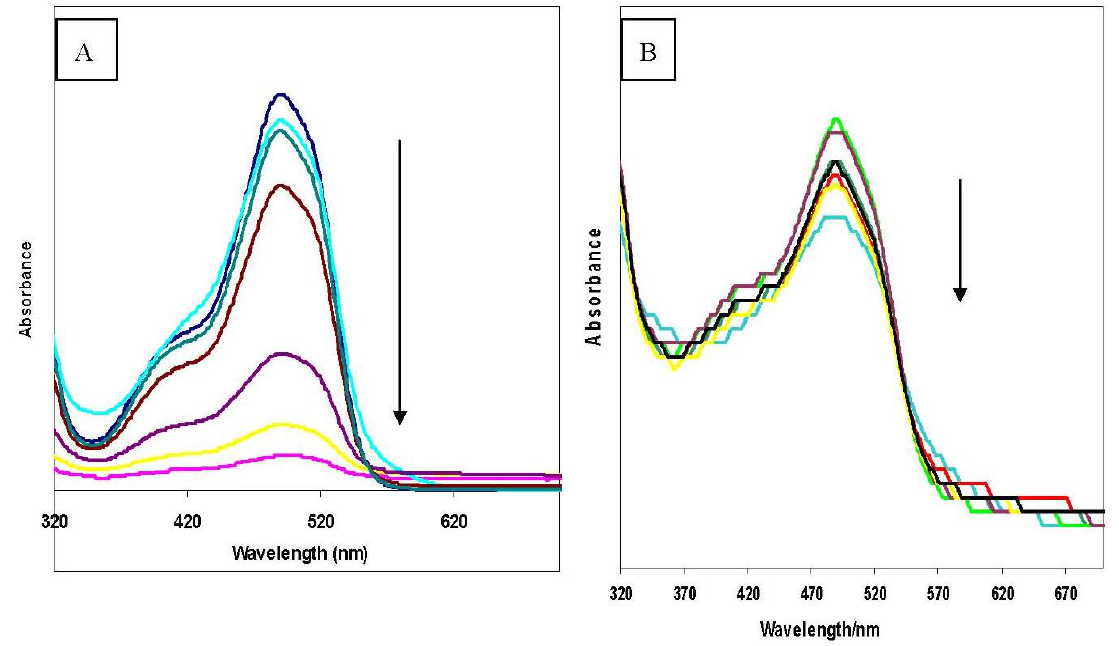
Figure 2. Fluorescence spectra of the azo dye CD polymer in different solvents. (λ